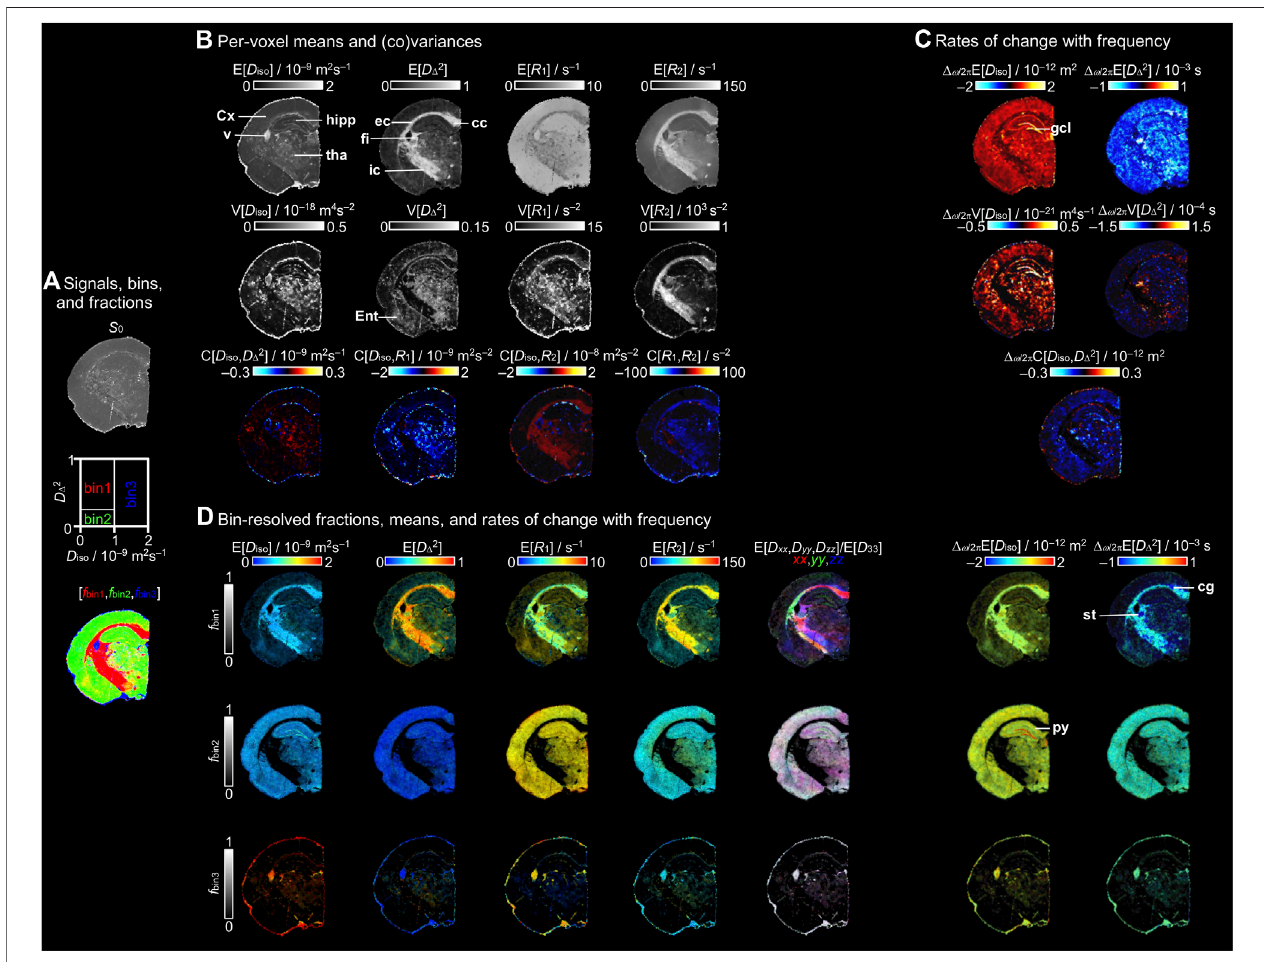
FIGURE 3 | Parameter maps derived from the per-voxel D ( ω )- R 1 - R 2 distributions. (A) S 0 map displayed in gray scale, diagram with the division of the 2D D iso - D Δ 2 projection into three bins (bin1,bin2,bin3), and the resulting signal fractions ( f bin1 , f bin2 , f bin3 ) coded into RGB color. (B) Per-voxel means E[ x ], variances V[ x ], and covariances C[ x , y ] for the D iso, D Δ 2 , R 1 , and R 2 dimensions at a selected encoding frequency ω /2 π (cid:2) 50 Hz. (C) Parameter maps of the rate of change with frequency Δ ω 2 . (D) Bin-resolved maps of E[ x ] and Δ ω /2 π of the per-voxel means, variances, and covariance of D iso and D Δ /2 π E[ x ]. The brightness and color scales represent, respectively,thesignalfractionsandthevaluesofeachparameter.Directionally-encodedcolor(DEC)mapsareobtainedfromthelab-framediagonalvalues[ D xx , D yy , D zz ] normalized by the maximum eigenvalue D 33 . Labeled lines indicate selected anatomical structures mentioned in the text. Abbreviations: cc, corpus callosum;